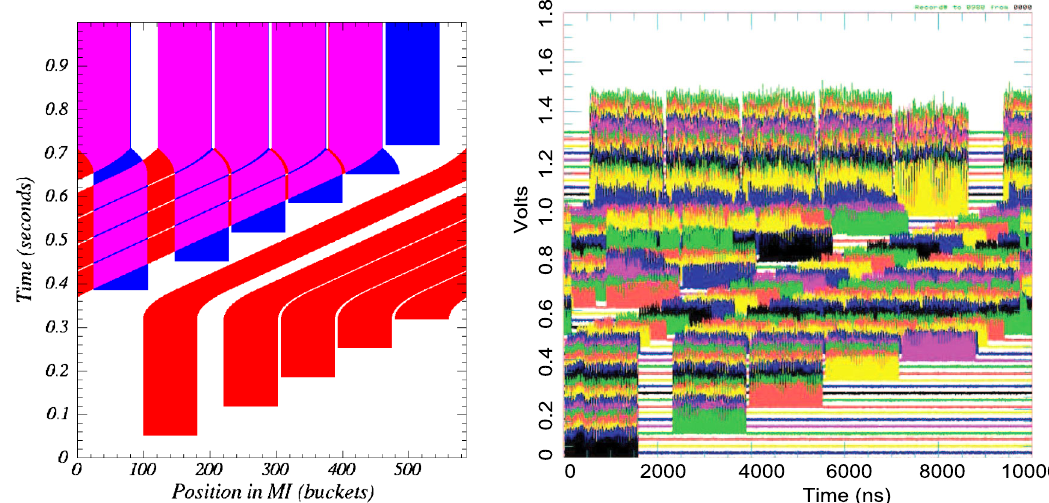
FIG. 4. Left panel shows logic of slip stacking (see Sec. IVA). Five (red) Booster batches are injected into buckets of the first rf system. The frequency is reduced to decelerate them and the next five (blue) batches are injected. When the bunches in the red and blue batches are aligned, the 1 MV rf system captures them. Then the final blue batch is injected. Right panel shows wall current monitor signal during injection for slip stacking operation using 11 Booster batches. Horizontal axis shows time for (nearly) one Main Injector revolution. Main Injector revolution time is 11134 ns at injection. Vertical axis shows bunch intensity with later turns offset vertically. Four double batches followed by one single batch for neutrino production are phased for acceleration at the top of the figure. The first injected batch for pbar production begins at the lower left, slips to the right and is joined by the second pbar injection, arriving at acceleration phase before the top of the figure where it is at the far right. The final neutrino batch arrives following the recapture to the left of the gap for pbar extraction. This panel is from Ref. [1]. With this mode, Main Injector intensities of up to 4 : 6 (cid:1) 10 13 protons per cycle are achieved.